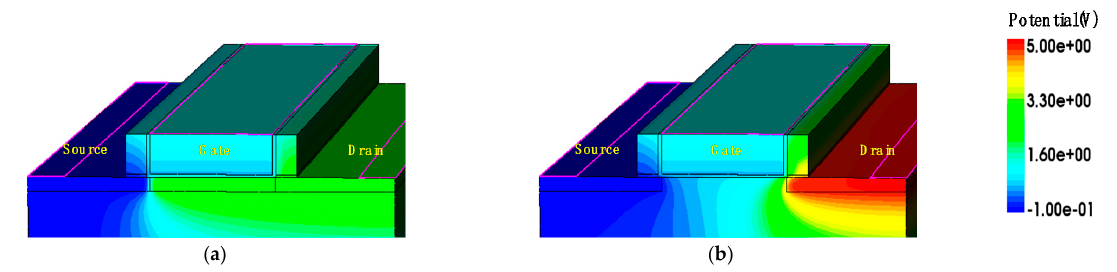
Figure 7. Contour plot of potential of ( a ) SiGe PNN TFET and ( b ) Conventional TFET.